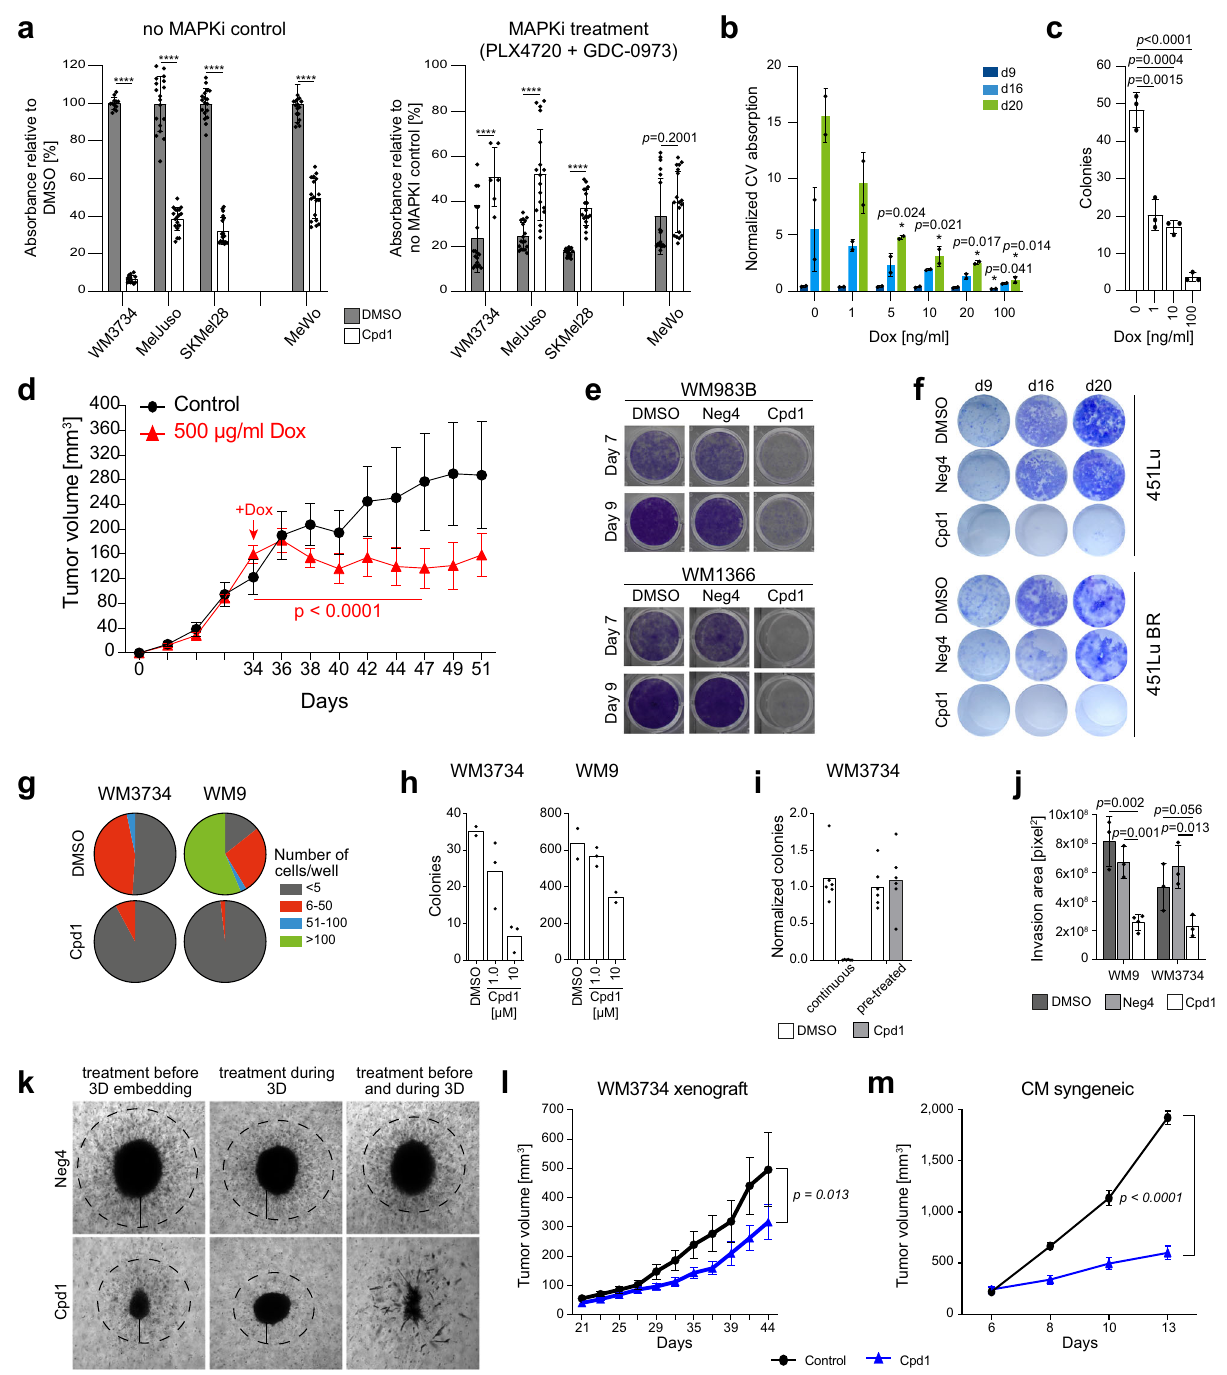
cells ( p = 0.0033) (Fig. 3e). Importantly, the Cpd1-mediated increase of midbodies was rescued by SLF ′ -thalidomide-induced degradation of KDM5B in WM3734 Tet3G-KDM5B-FKBP12 cells (Fig. 3f). Transcriptional and proteomic pro fi ling of KDM5B- enforced WM3734 cells by RNAseq and label-free quantitative mass spectrometry after 72 h of 10 µM Cpd1 revealed a small overlap of 11 genes/proteins, of which 7 have known functions during cytokinesis (Fig. 3g and Supplementary Data 1 highlighted in bold). For example, AURKB , MKI67 , KIF4A , UBE2C , RRM2 , KIF1C1 , and ANLN are attributed to the GO cytoskeleton- dependent cytokinesis. For the expression of a subset of genes ( AURKB , KIF4A , SHCBP1 , and UBE2C ), we found a